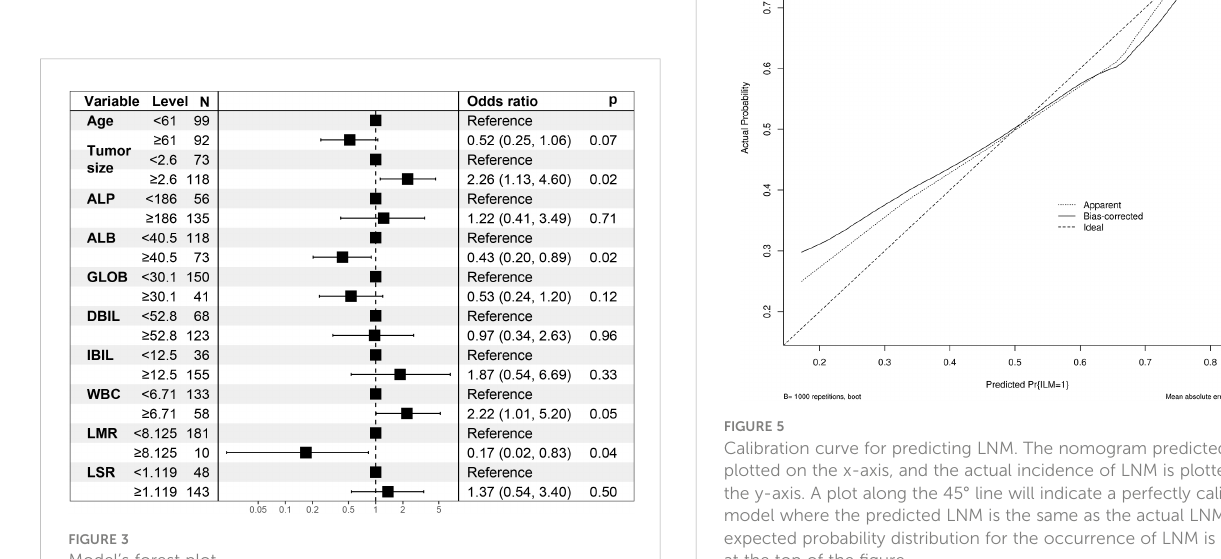
FIGURE 3 Model ’ s forest plot.